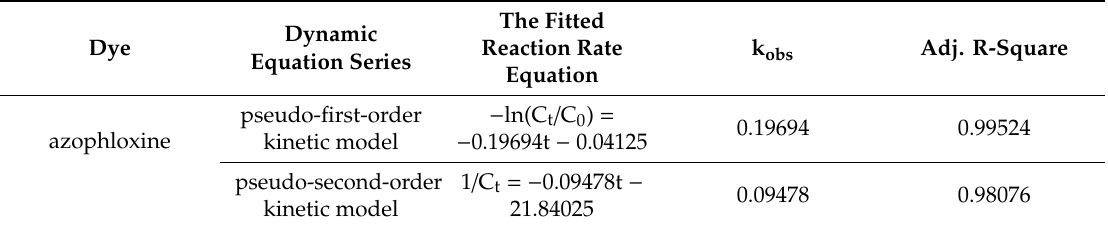
Table 1. Kinetic constants of azophloxine degradation by the FeAlg-ACFs / PMS / visible light system.